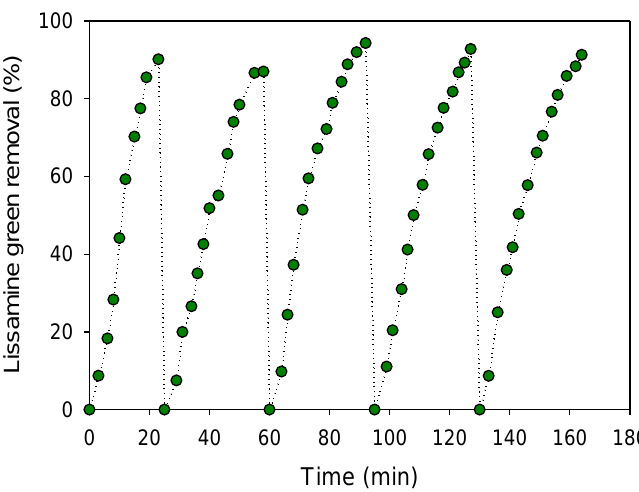
Figure 7. Reusability of catalyst in order of lissamine green removal at laboratory scale. Experimental